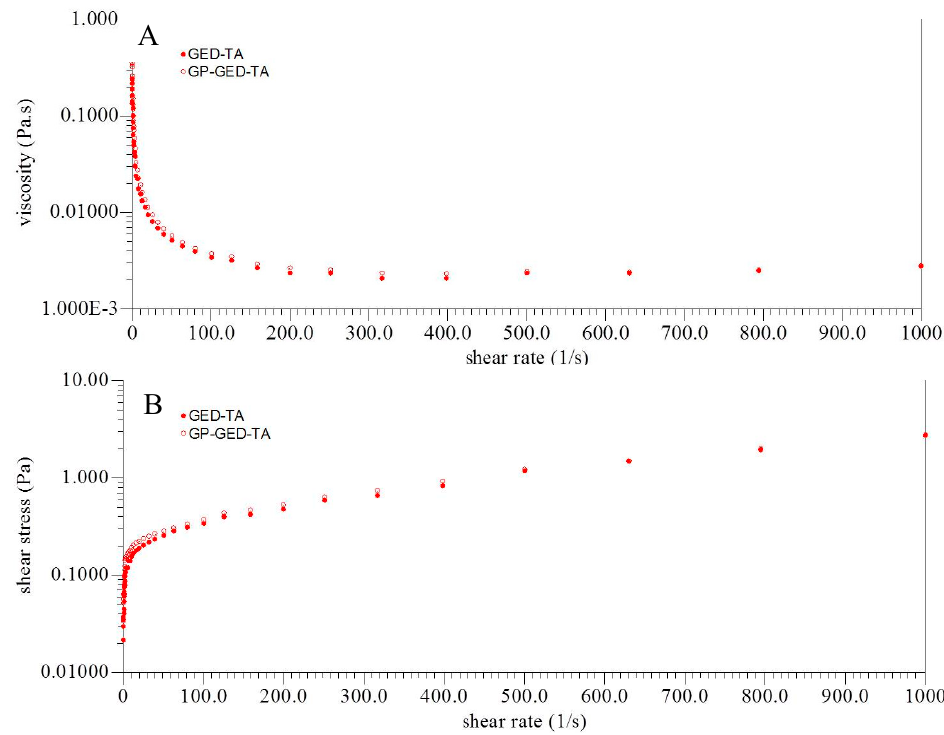
Figure 7. Shear-rate dependence of viscosity ( A ) and shear stress ( B ) for emulsions prepared with GED-TA or GP-GED-TA.